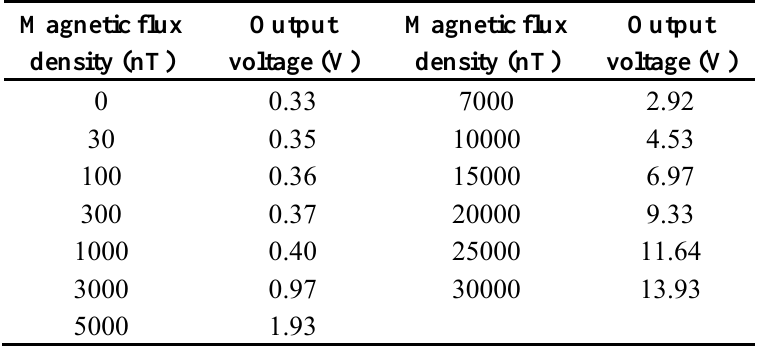
Table 2. The test data of the magnetometer prototype